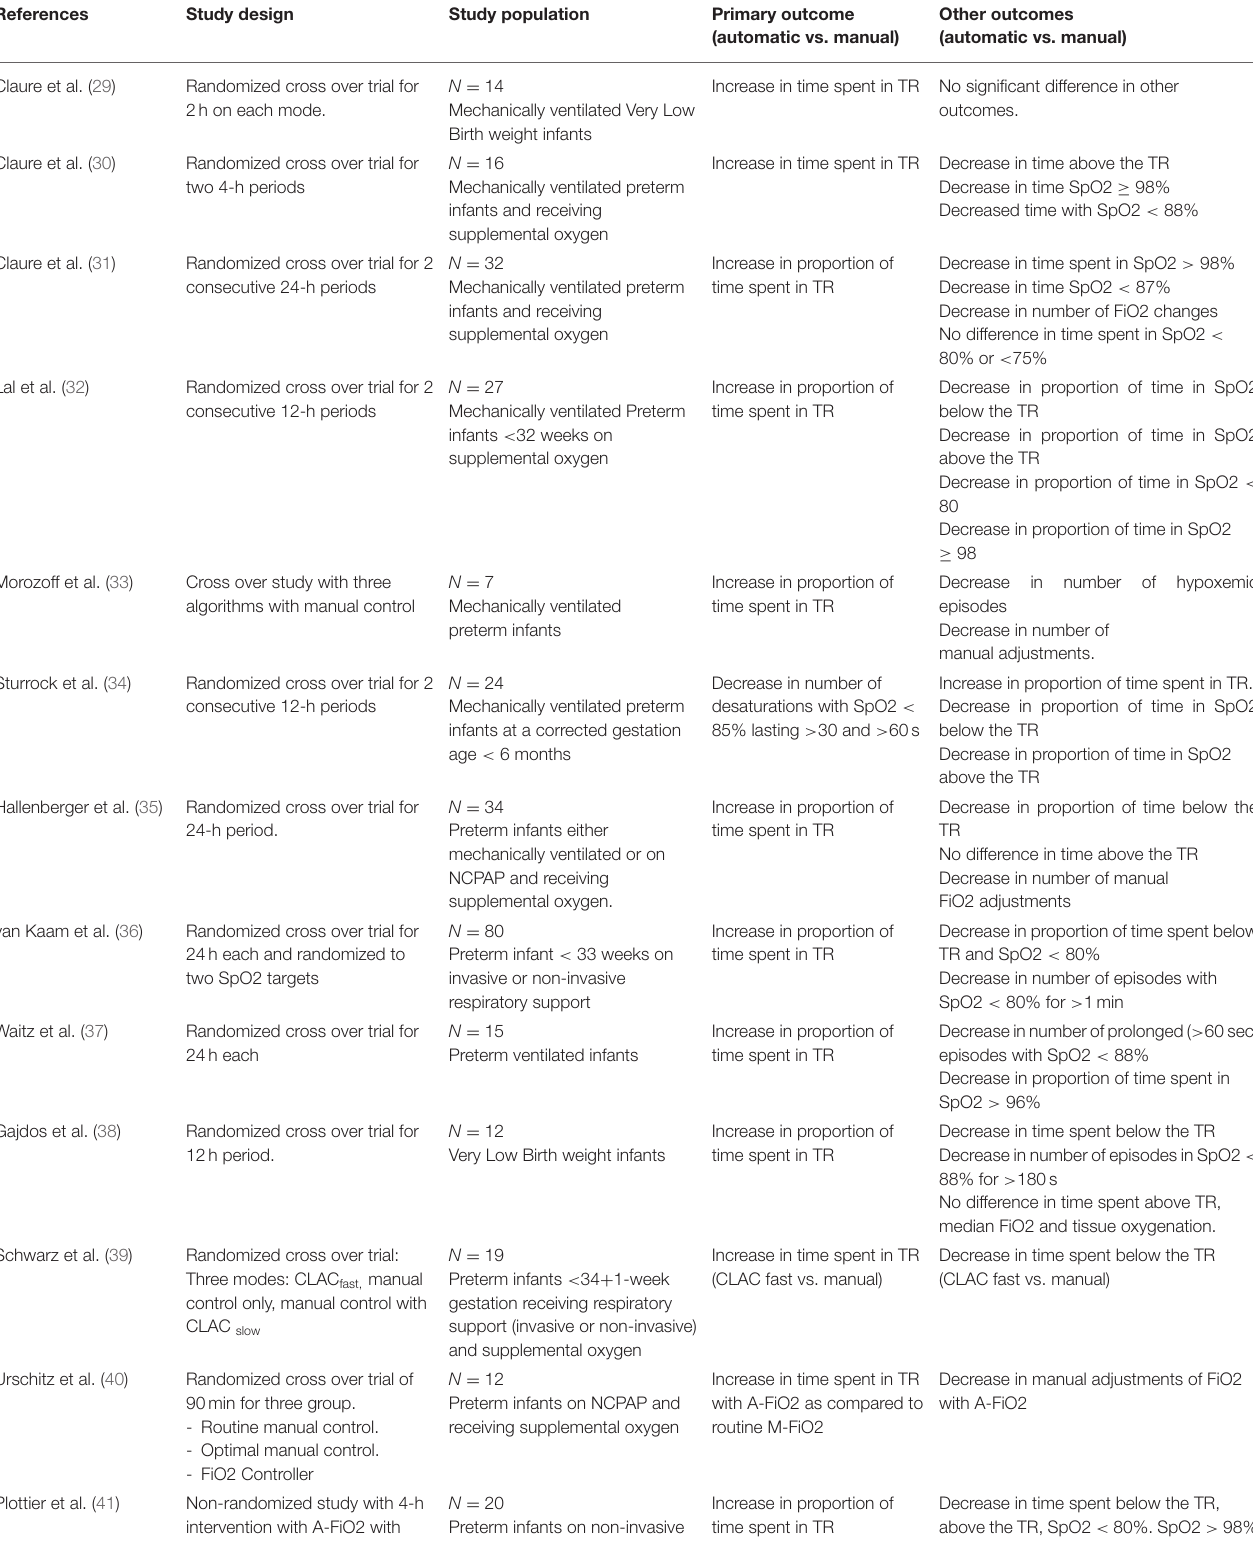
TABLE 1 | Characteristics of A-FiO2